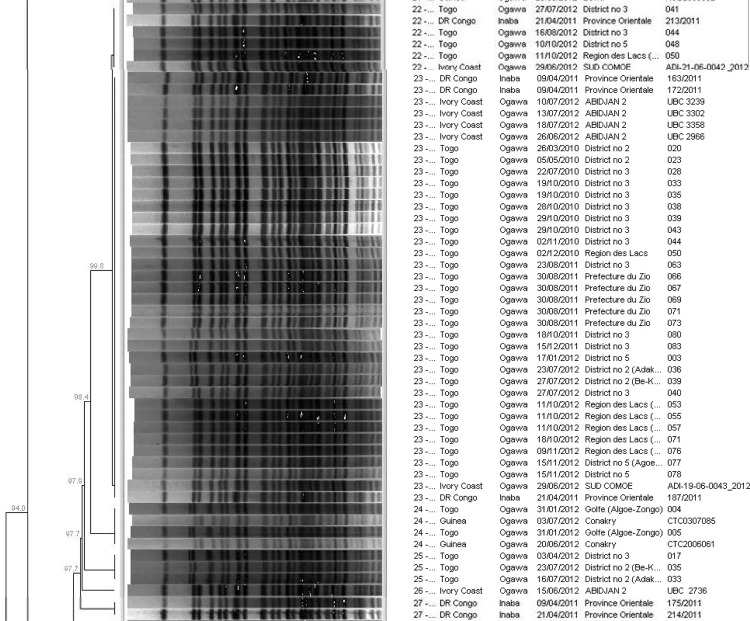
Snapshot of dendrogram of PFGE (NotI digestion) patterns for V. cholerae O1 isolates.